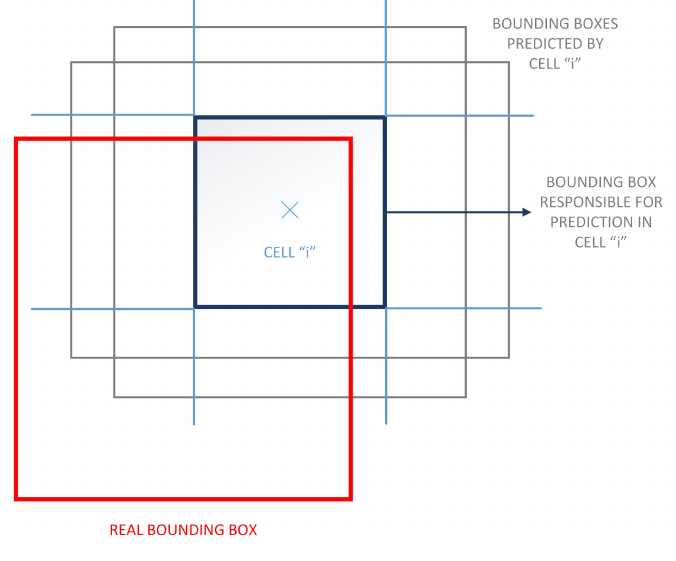
Figure 5. Bounding box responsible for